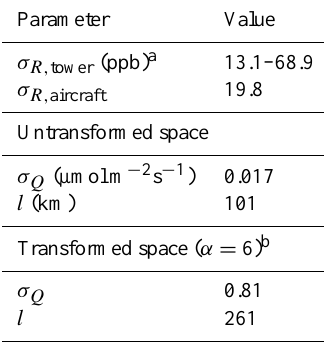
Table 1. Covariance matrix